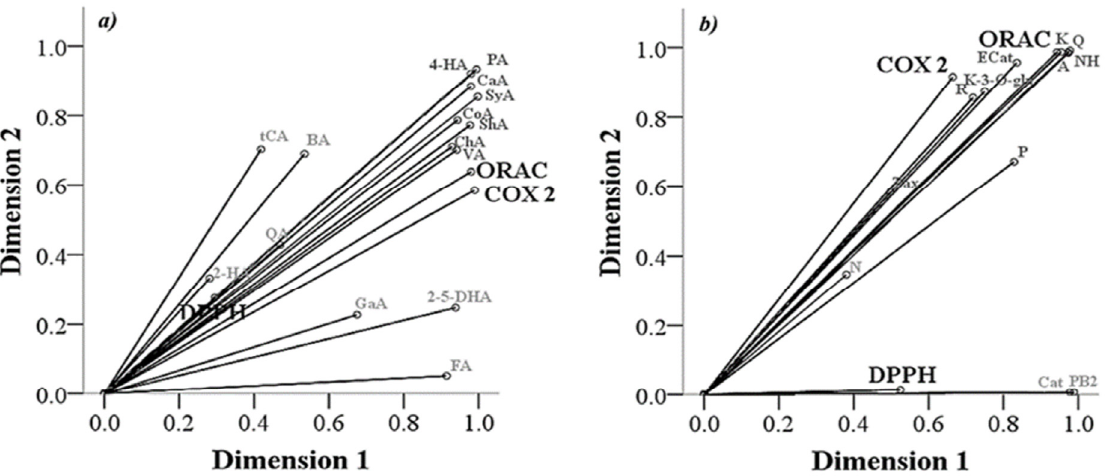
Figure 4. Optimal scaling analysis of polyphenols from Quince fruit ( Cydonia oblonga Mill.) extract. Relationship between polyphenols and in vitro biological effects. ( a ) Phenolic acids and ( b ) flavonoids compounds.